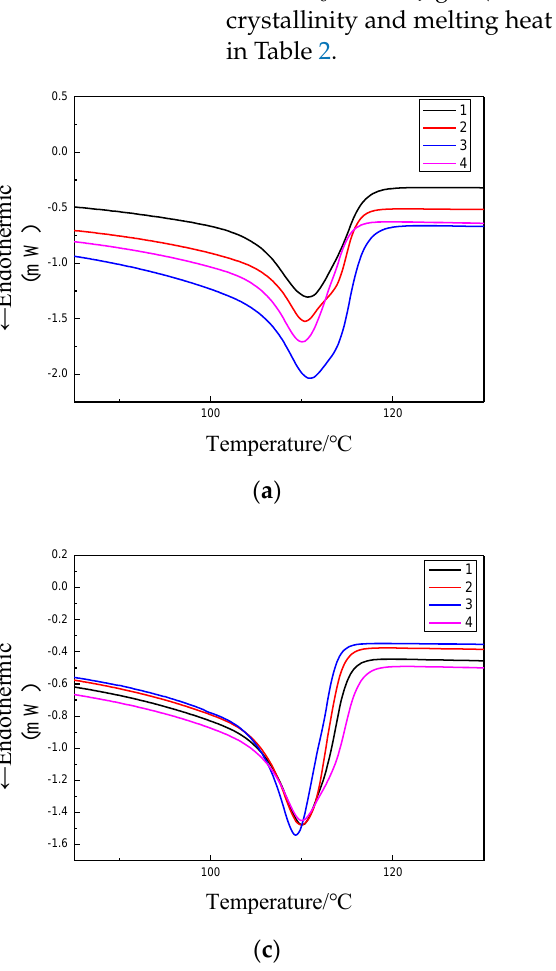
Figure 5. DSC curves of each sample. ( a ) Tensile rate 0%; ( b ) Tensile rate 5%; ( c ) Tensile rate 10%; ( d ) Tensile rate 20%.